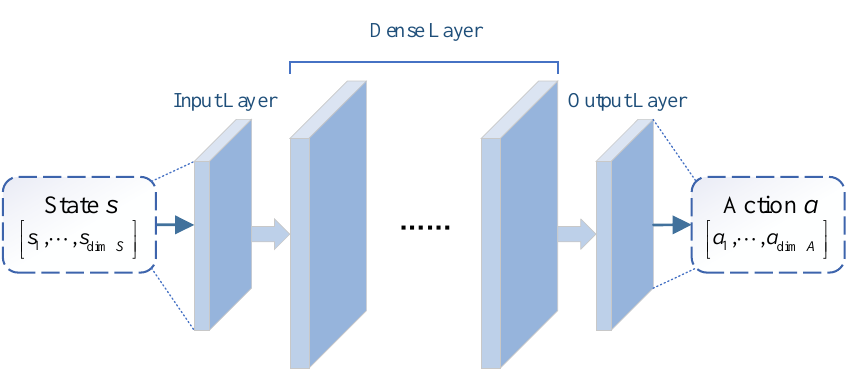
Figure 5. The structure of actor network.